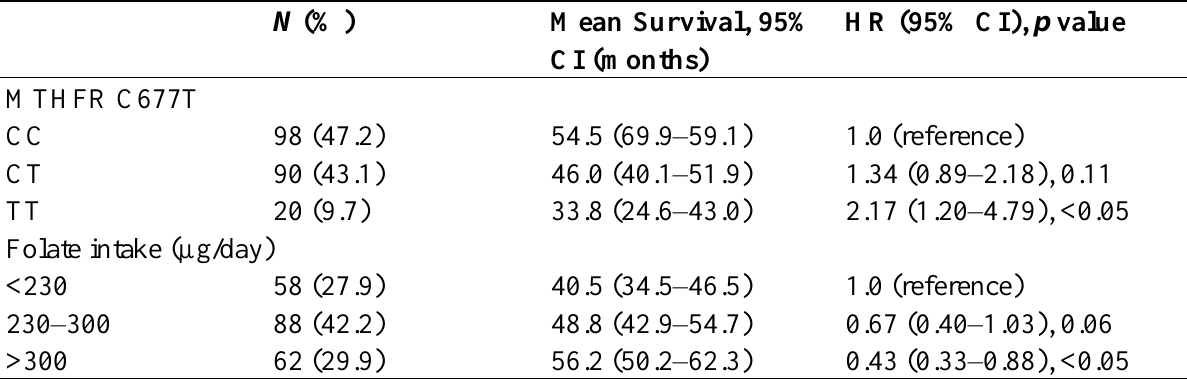
Table 3. Kaplan-Meier survival estimation of median survival and HRs with MTHFR C677T gene polymorphism.